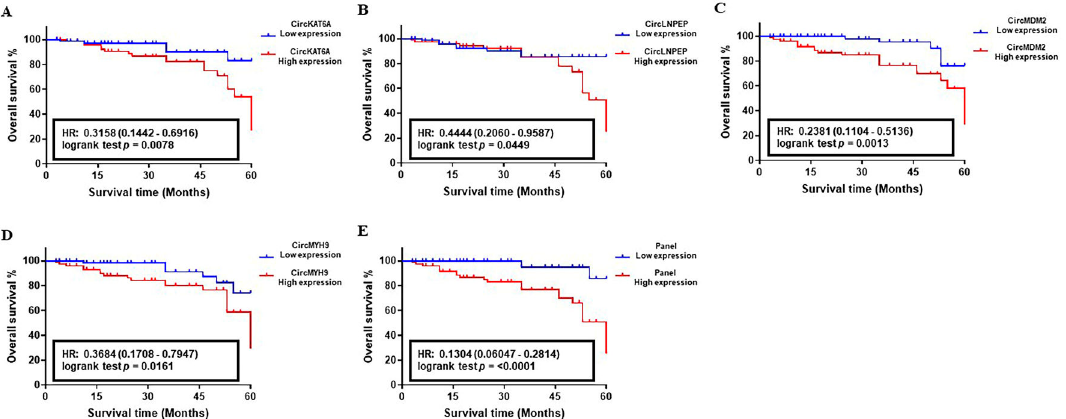
Figure 6. Correlation between the abnormal expression of candidate circRNAs and overall sur- vival (OS) of CLL in validation set I ( n = 220). ( A – D ) Survival impact of CircKAT6A, CircLNPEP, CircMDM2, and CircMYH9 as individual biomarkers, and ( E ) in the form of a panel in CLL. A Kaplan- Meier analysis indicated a reverse correlation between the high level of circRNAs individually and combined, and the worse survival of CLL patients in validation set